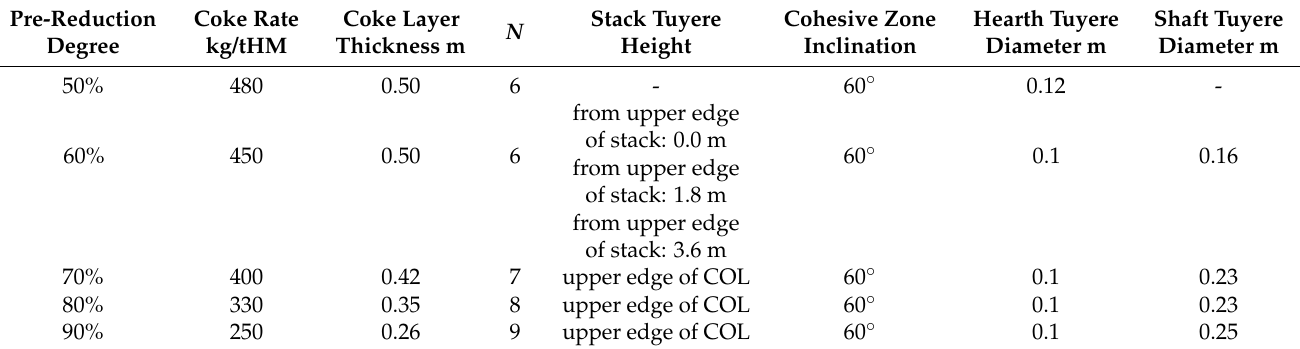
Table 5. Parameters and internal geometry of different pre-reduction degrees.